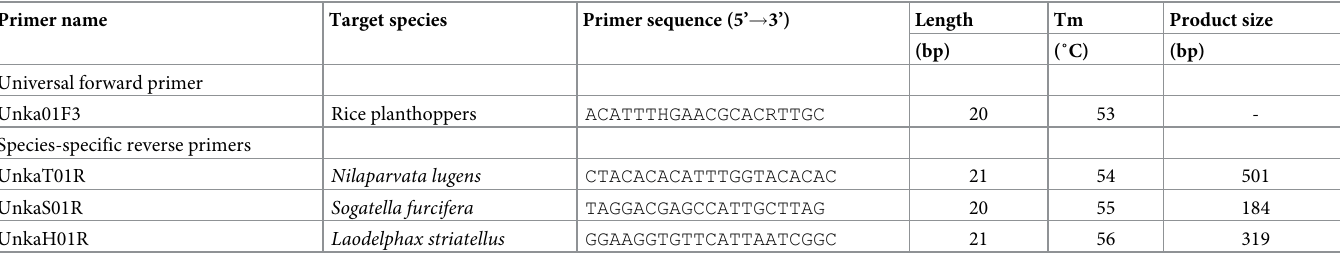
Table 1. Primers designed for the multiplex PCR assay in this